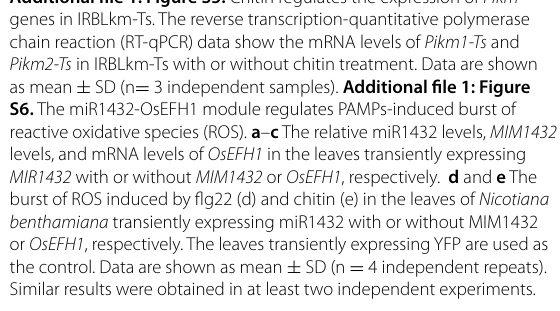
Additional file 1: Figure S5. Chitin regulates the expression of Pikm genes in IRBLkm‑Ts. The reverse transcription‑quantitative polymerase chain reaction (RT‑qPCR) data show the mRNA levels of Pikm1-Ts and Pikm2-Ts in IRBLkm‑Ts with or without chitin treatment. Data are shown as mean SD (n 3 independent samples). Additional file 1: Figure ± = S6. The miR1432‑OsEFH1 module regulates PAMPs‑induced burst of reactive oxidative species (ROS). a – c The relative miR1432 levels, MIM1432 levels, and mRNA levels of OsEFH1 in the leaves transiently expressing MIR1432 with or without MIM1432 or OsEFH1 , respectively. d and e The burst of ROS induced by flg22 (d) and chitin (e) in the leaves of Nicotiana benthamiana transiently expressing miR1432 with or without MIM1432 or OsEFH1 , respectively. The leaves transiently expressing YFP are used as the control. Data are shown as mean SD (n 4 independent repeats). ± = Similar results were obtained in at least two independent experiments. Additional file 2: Table S1. The agronomical traits of the indicated lines. Table S2. Primers used in this